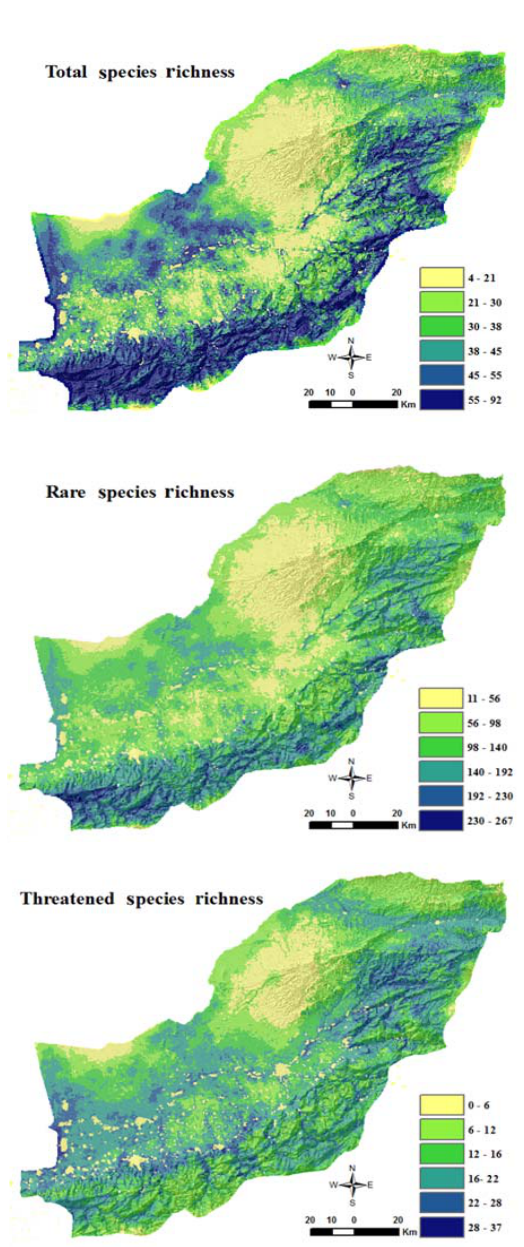
Fig. 3: Species richness of birds of Golestan Province, viewed in terms of total species richness, rare species richness, and threatened species richness